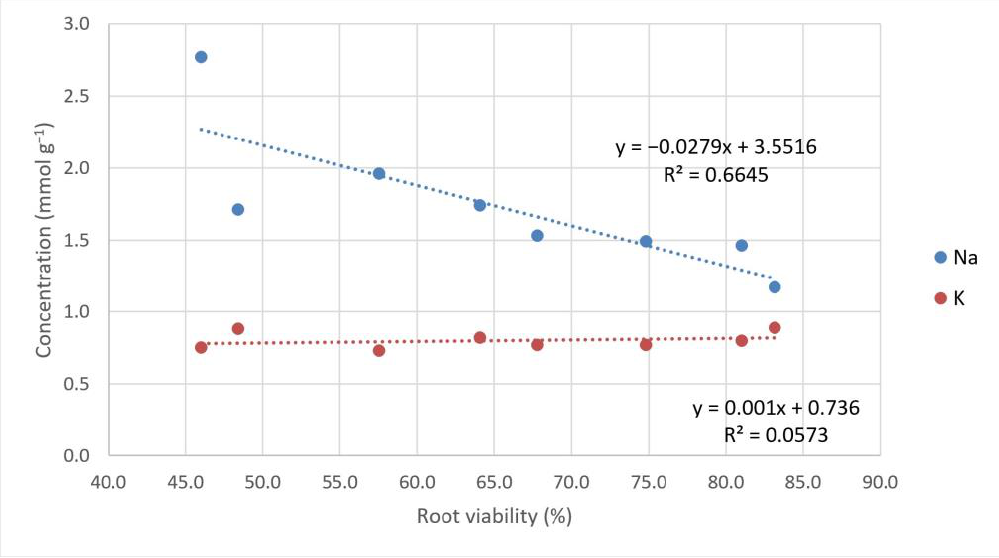
Figure 1. The interaction between root viability and the concentration of sodium and potassium in leaves of eight rice varieties at the seedling stage. The diagram contains all of the examined varieties. The dots represent the mean of three different measurements.